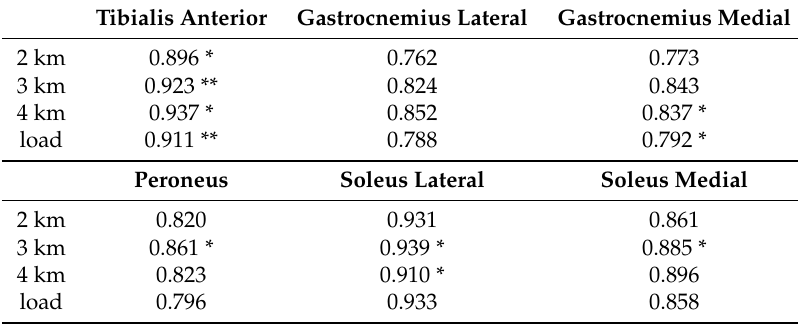
Table 6. Median temporal accuracy [%] of each task of the proposed method (* p < 0.05, ** p < 0.01).